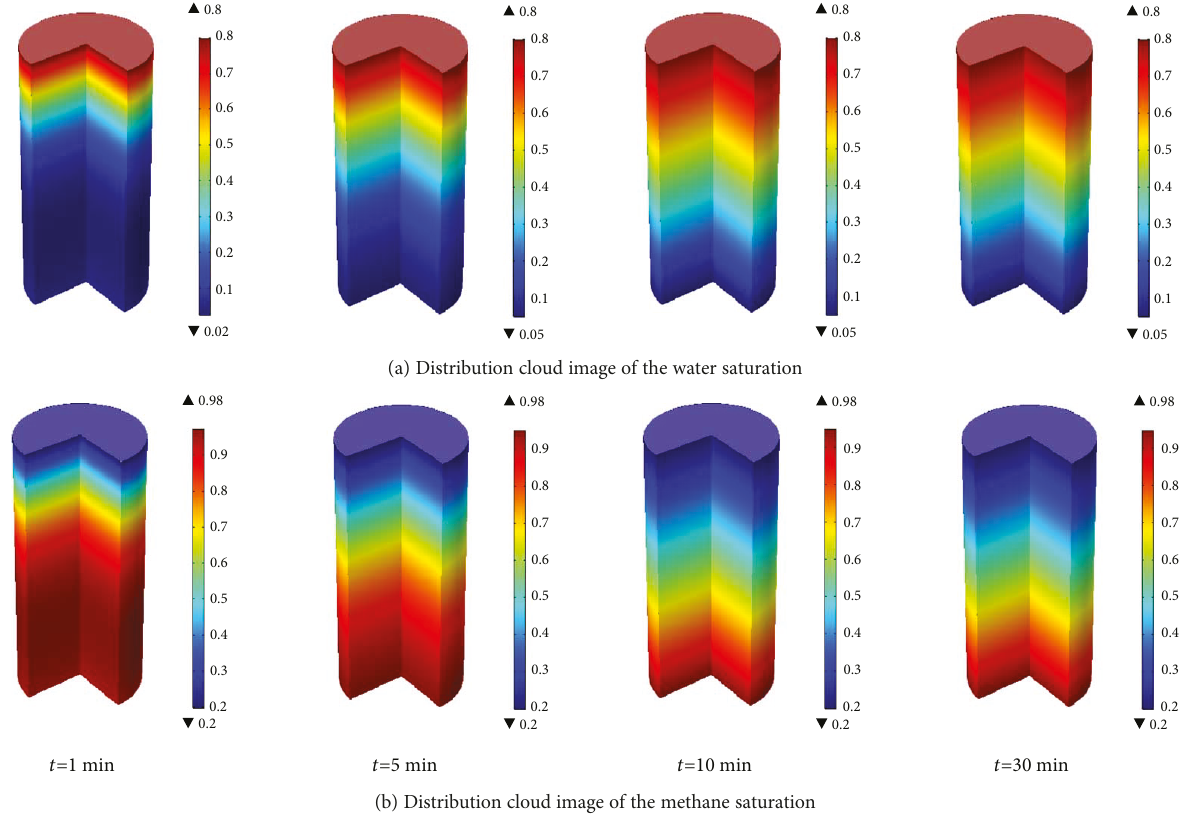
Figure 8: Space-time distribution of the water-methane two-phase